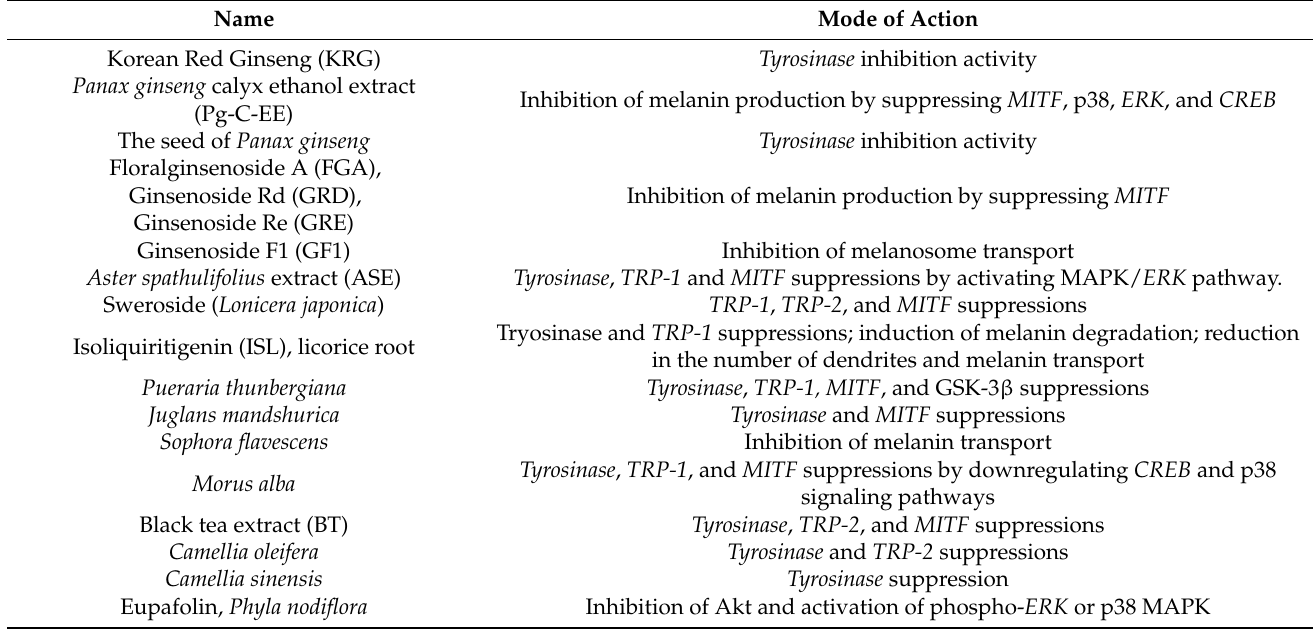
Table 1. List of skin-whitening agents derived from